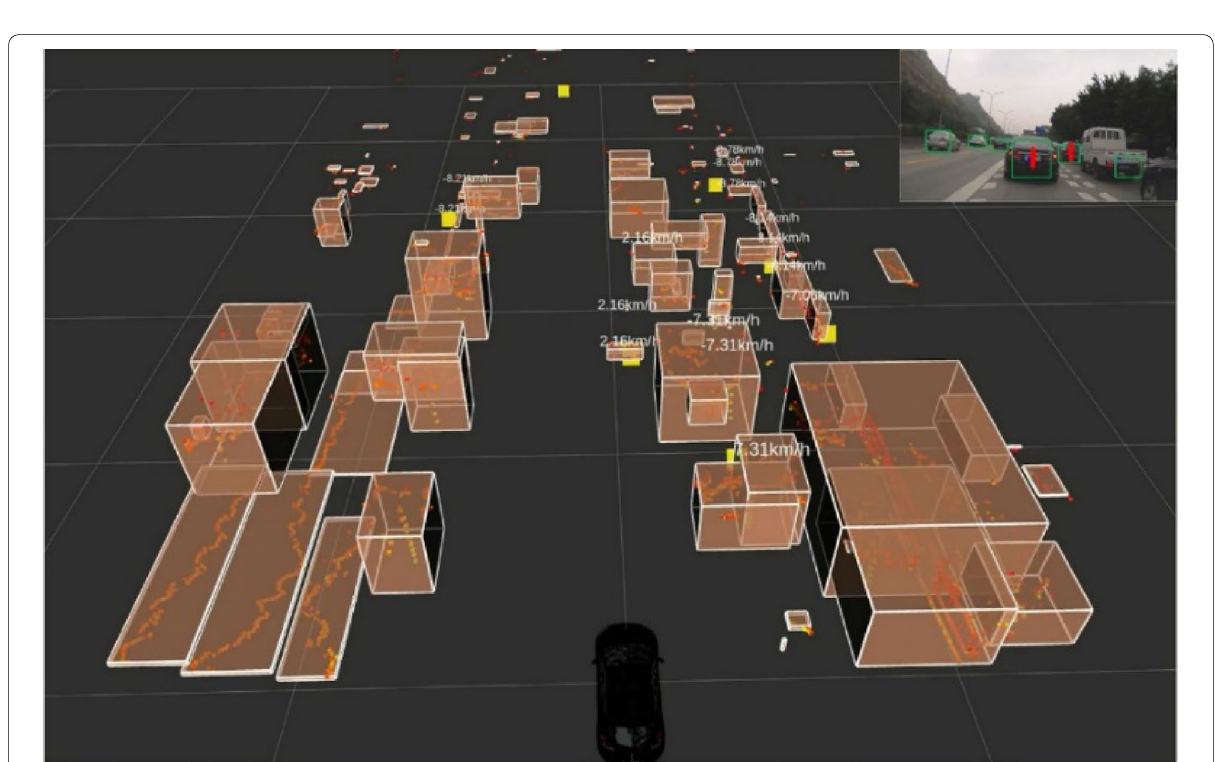
Figure 7 Our algorithm is performing real car